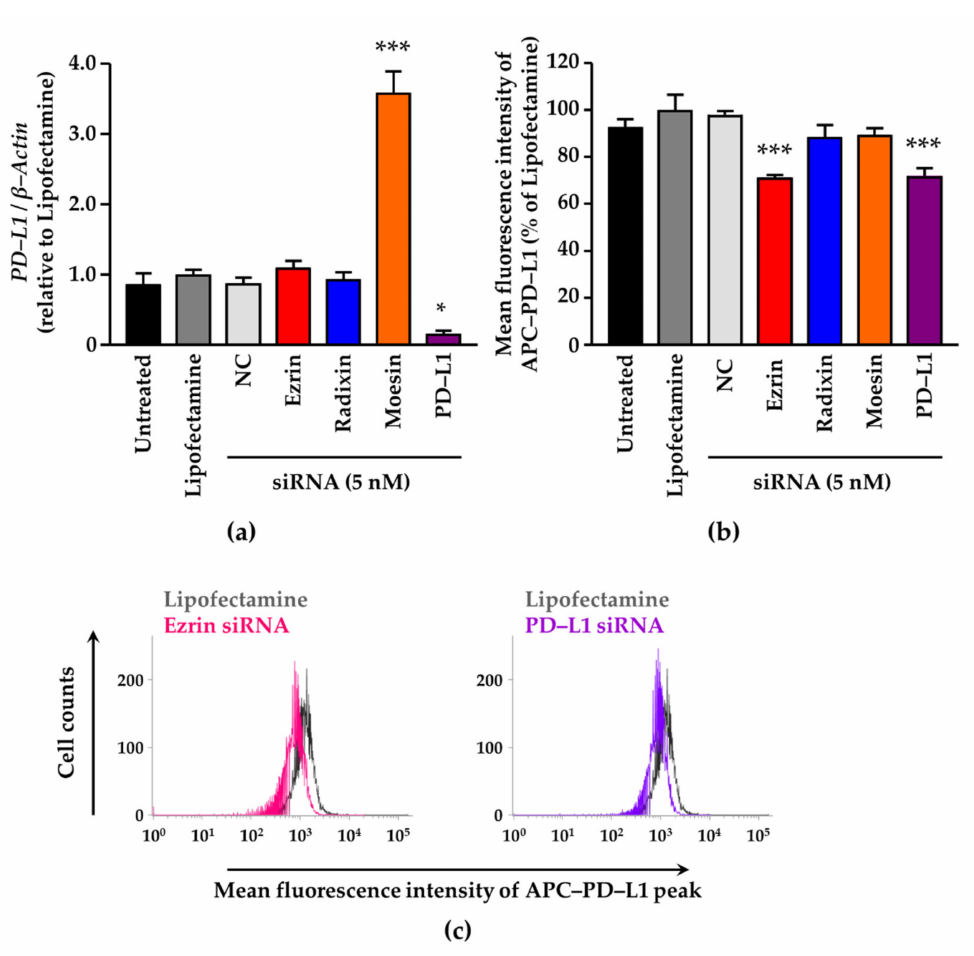
Figure 5. Involvement of ezrin, radixin, and moesin in the gene and cell surface expression of programmed death ligand–1 in A2780 cells. ( a ) Relative mRNA expression level of PD–L1 normalized to β –Actin in the cells treated with small interfering (si) RNAs relative to that in cells treated with the transfection reagent alone was measured using real-time reverse transcription–polymerase chain reaction. n = 3, *** p < 0.001, * p < 0.05 vs. Lipofectamine. ( b ) Relative mean fluorescence intensity of allophycocyanin (APC)-labeled PD–L1 on the plasma membrane of A2780 cells normalized to that of Lipofectamine alone. n = 3, *** p < 0.001 vs. Lipofectamine. ( c ) Typical histograms of the mean fluorescence intensities of APC-labeled PD–L1 on the plasma membrane of A2780 cells, as measured by flow cytometric analysis. All data are expressed as the mean ± SEM and were analyzed using one-way ANOVA, followed by Dunnett’s test. Non–targeting control;